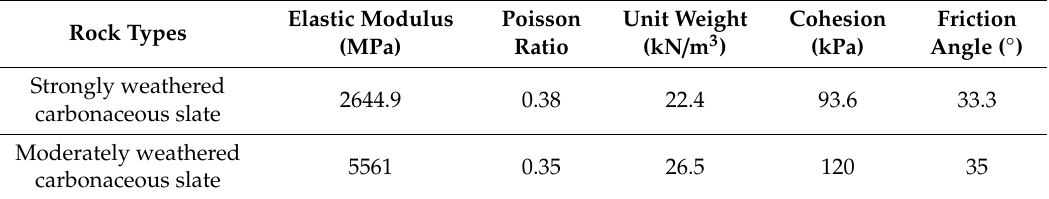
Table 4. Rock mass strength parameters.